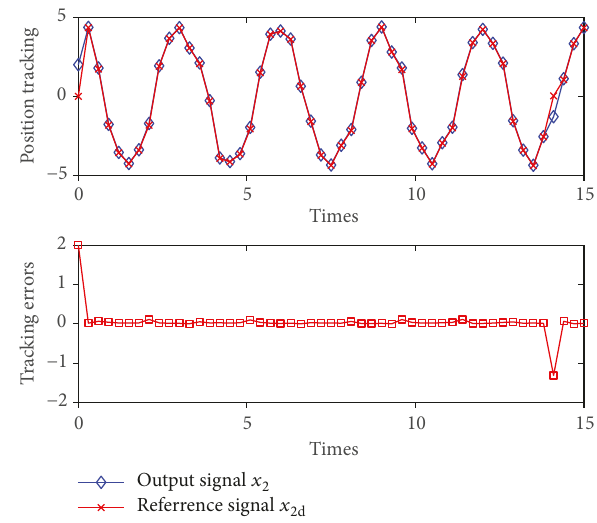
Figure 5: The control results and tracking error of x sin 2/3 π t .